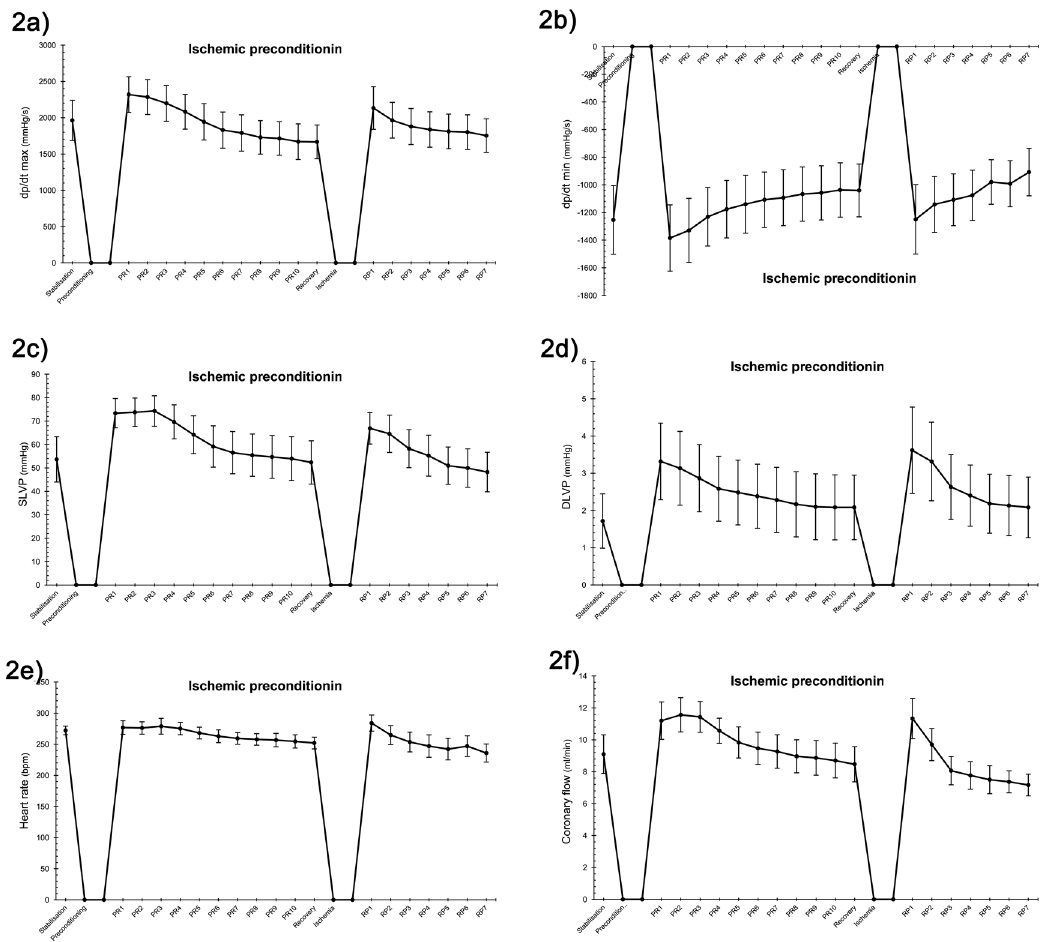
Fig. 2 - The influence of ischemic preconditioning (5 min ischemia/10 min reperfusion) on cardiodynamic parameters of the isolated rat heart during subsequent ischemia (20 minutes)/reperfusion (30 minutes): 2a) dp/dtmax, 2b) dp/dtmin, 2c) SLVP, 2d) DLVP, 2e) HR, 2f)